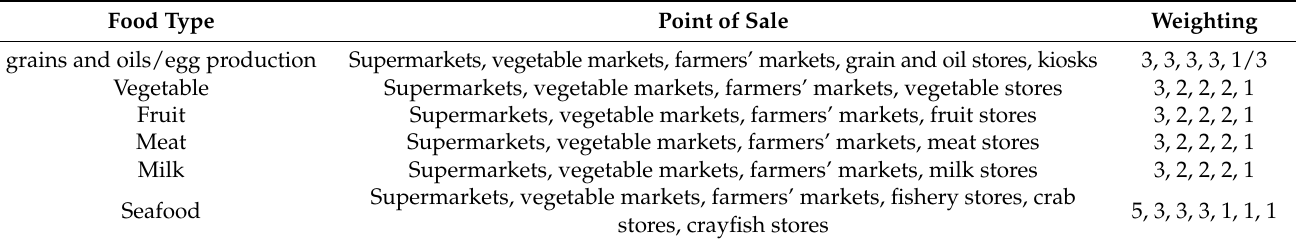
Table 1. Food types and stores types in